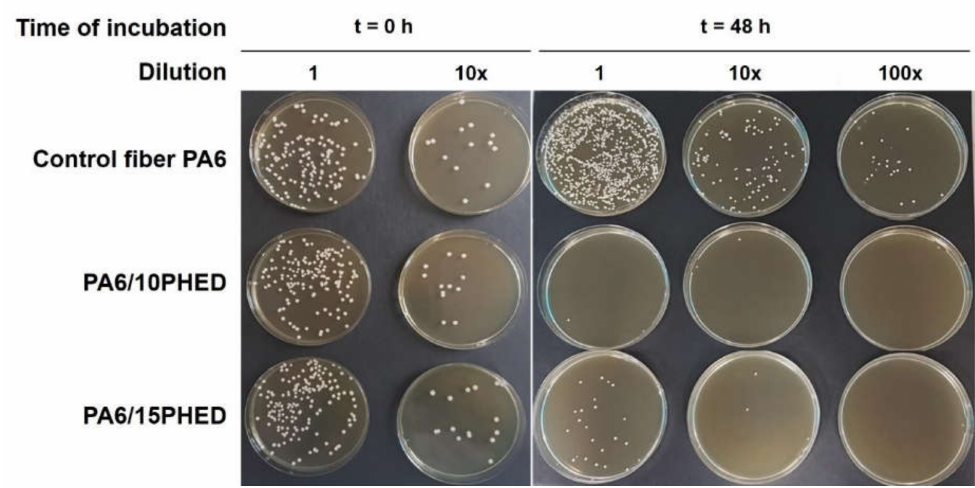
Figure 7. Growth of C. albicans after transferring the undiluted, 10 × diluted, and 100 × diluted inoculated samples prior to and after 48 h of